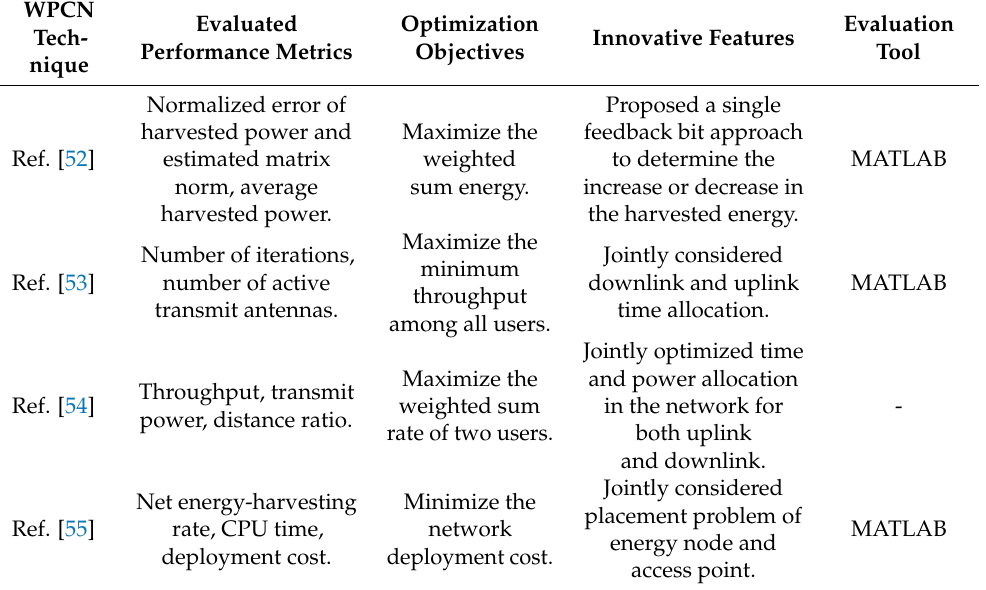
Table 10. Comparison of existing WPCN techniques in terms of design approach and main